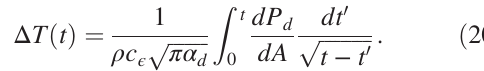
right.FIG. 12. Pulse heating maximum temperature rise for the maximum radii corrugation with a ¼ 1 mm, E and conductivity σ ¼ 4 × 10 7 S m − 1 for a= λ ¼ 0 . 53 (red), a= λ ¼ 0 . 60 (black), and a= λ ¼ 0 . 67